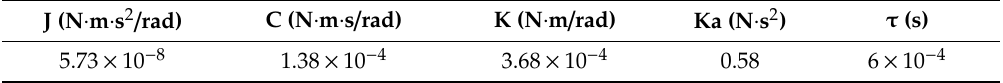
Figure 4. Three kinds of normal distribution noises and the corresponding increasing monotonicity numbers (IMN), ( a ) the noise that obeys N(0, 30 (cid:2870) ) aF, ( b ) IMN of the noise that obeys N(0, 30 (cid:2870) ) aF, ( c ) the noise that obeys N(0, 300 (cid:2870) ) aF, ( d ) IMN of the noise that obeys N(0, 300 (cid:2870) ) aF, ( e ) the noise that obeys N(50, 300 (cid:2870) ) aF, ( f ) IMN of the noise that obeys N(50, 300 (cid:2870) ) aF. Table 2. Mechanism parameters used in the